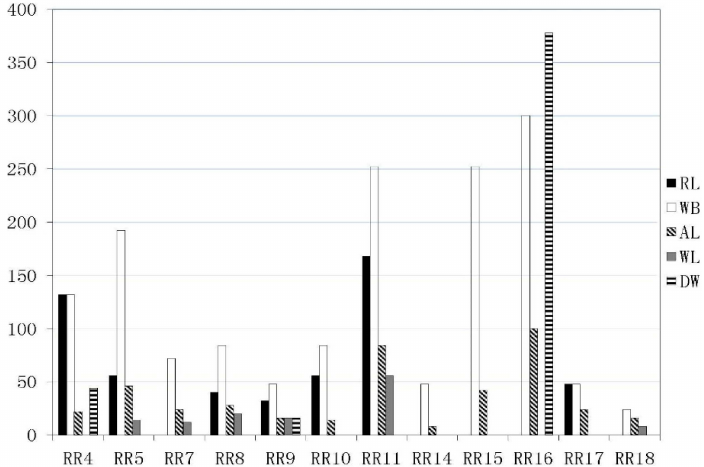
Figure 5. Risk score by each receptor for sub-watersheds RR1-22 (excluding no-risk sub-watersheds). The abbreviations in the legend are as follows: RL is residential land; WB is water body; AL is agricultural land; WL is woodland; DW is drinking water